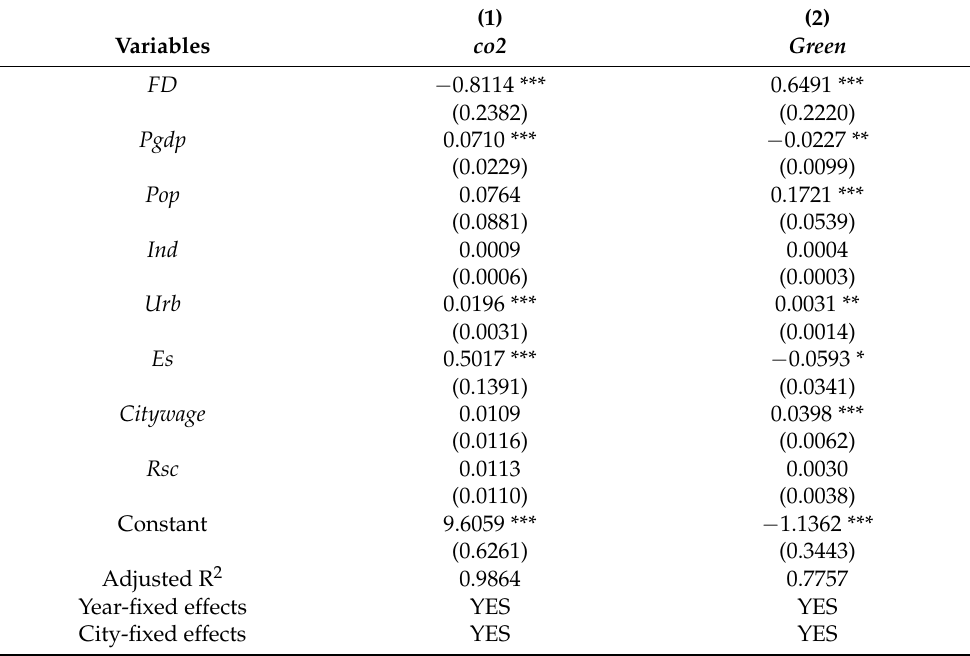
Table 2. Results on carbon emissions and green innovation at the city